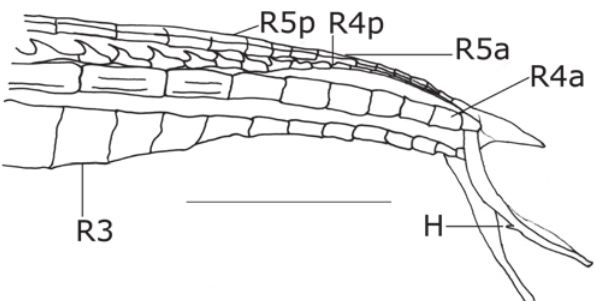
Fig. 51. Gonopodium tip of Phalloceros reisi , MCP 20579. (a) ventrolateral view; (b) lateral view. R3, R4a, R4p, R5a, R5p indicate gonopodial rays. H = hook. Scale bar 1